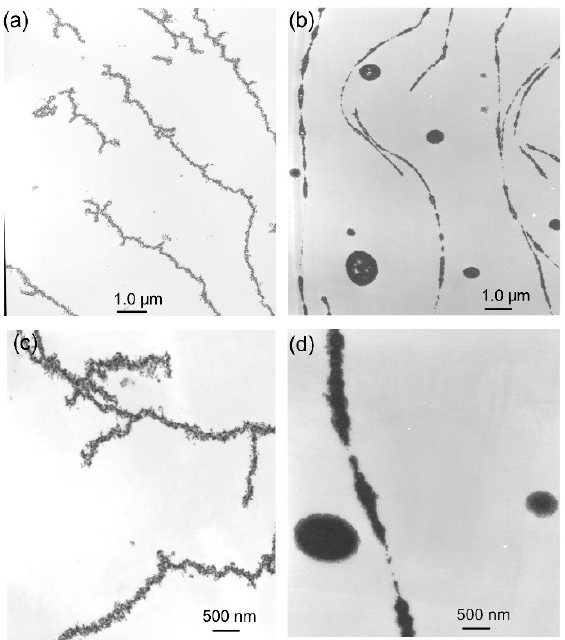
Figure 4. TEM micrographs of the PVB ‐ ATOu ‐ 5 ( a , c ) and PVB ‐ ATOc ‐ 5 ( b , d ) composite films.